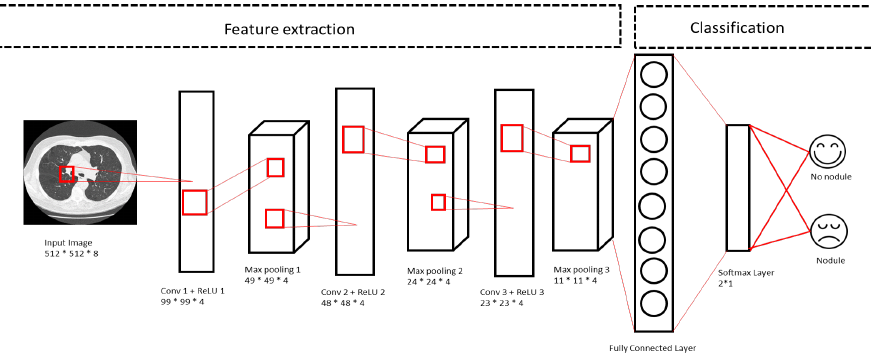
Figure 5. Selected nodule candidates from the features of the lung CT